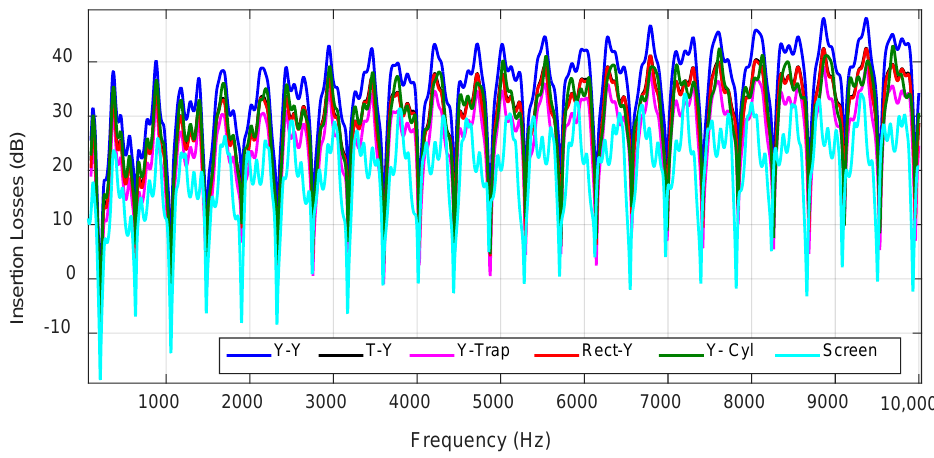
Figure 18. IL in Configuration 3 (‘Ambulance–Person’) using double caps formed with Y-shaped structures and a single screen barrier as a reference.